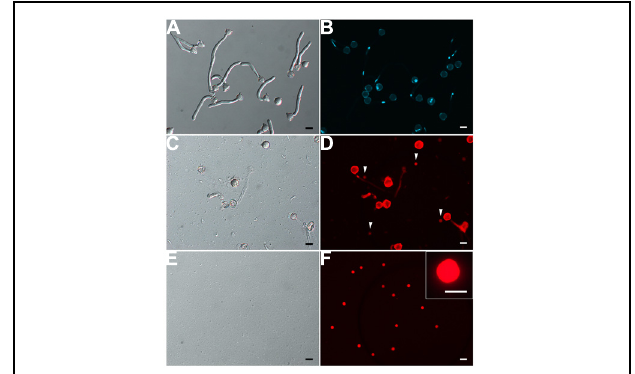
FIGURE 5 | Isolation of VN from pollen tubes. (A,B) DIC (A) and DAPI staining (B) of pollen tubes cultured in vitro for 1.5 h. (C,D) DIC microscopy (C) and propodium iodide (PI) staining (D) of enzymolysis-treated pollen tubes; arrows indicate released VNs (D) . (E,F) DIC microscopy (E) and PI staining (F) of purified VN . Inset image in (F) is close-up of a PI-stained VN. Scale bar: 20 μ m in (A) to (F) , 10 μ m in the inset image (F)